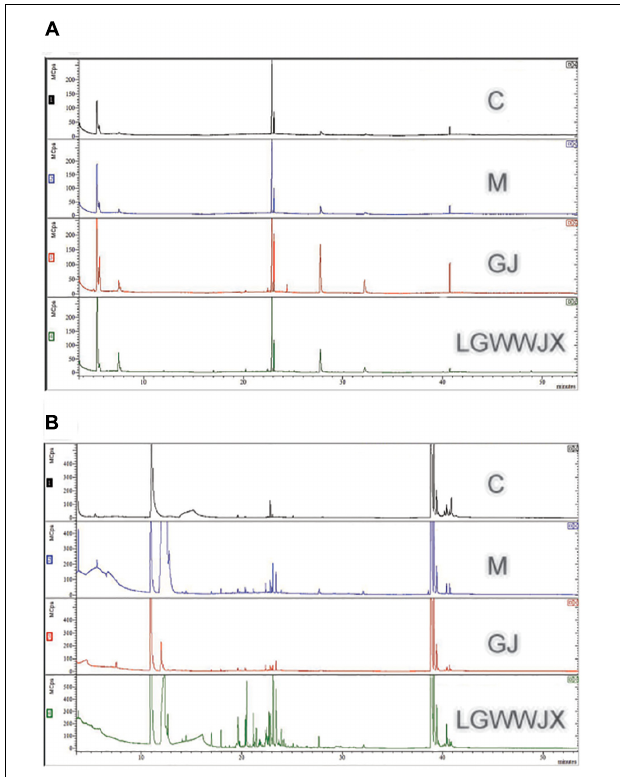
FIGURE 2 | Representative GC–MS TIC chromatograms of control (C), model (M), Gan Jiang (GJ) decoction, and LGWWJX decoction groups in rat serum (A) and urine (B)